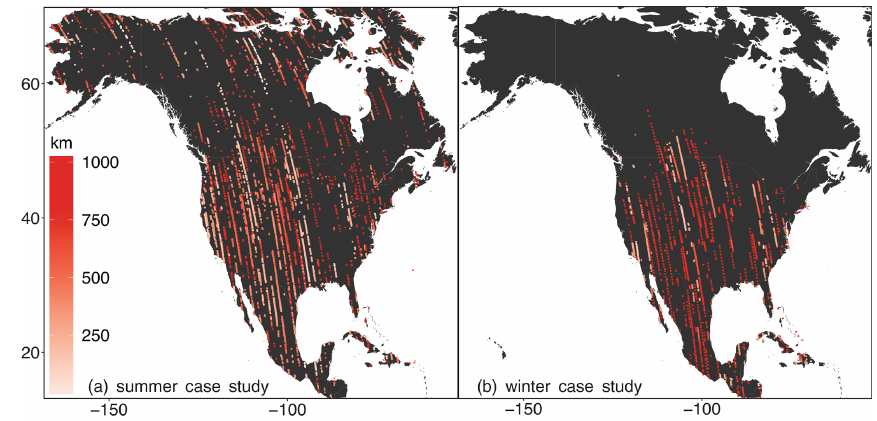
Figure 1. Correlation lengths estimated along OCO-2 flight tracks for (a) the summer synthetic case study and (b) the winter synthetic case study. The estimated correlation lengths are typically shorter in summer when biospheric fluxes exhibit high spatiotemporal variability and longer in winter when biospheric fluxes are small.